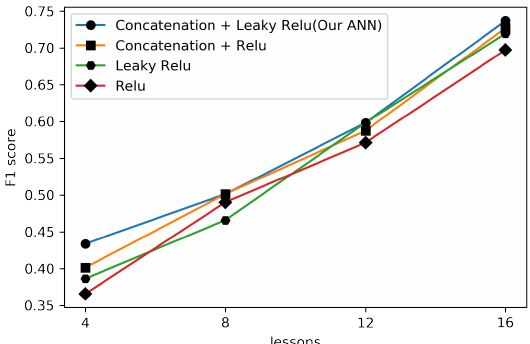
Figure 9. Performance comparison on different ANN model architecture